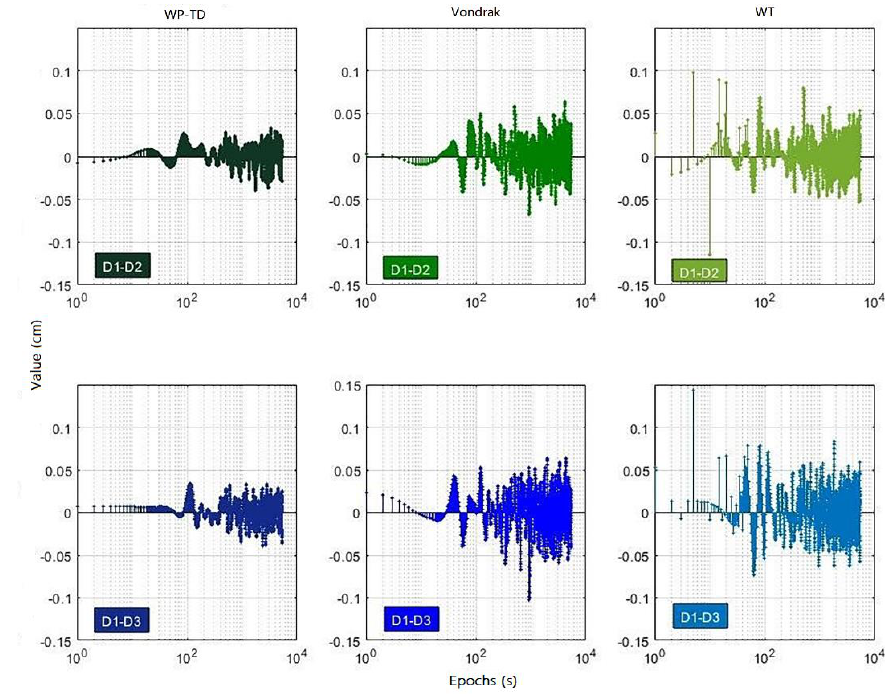
Figure 11. The difference of DD coordinate residual sequences denoised by the three algorithms.